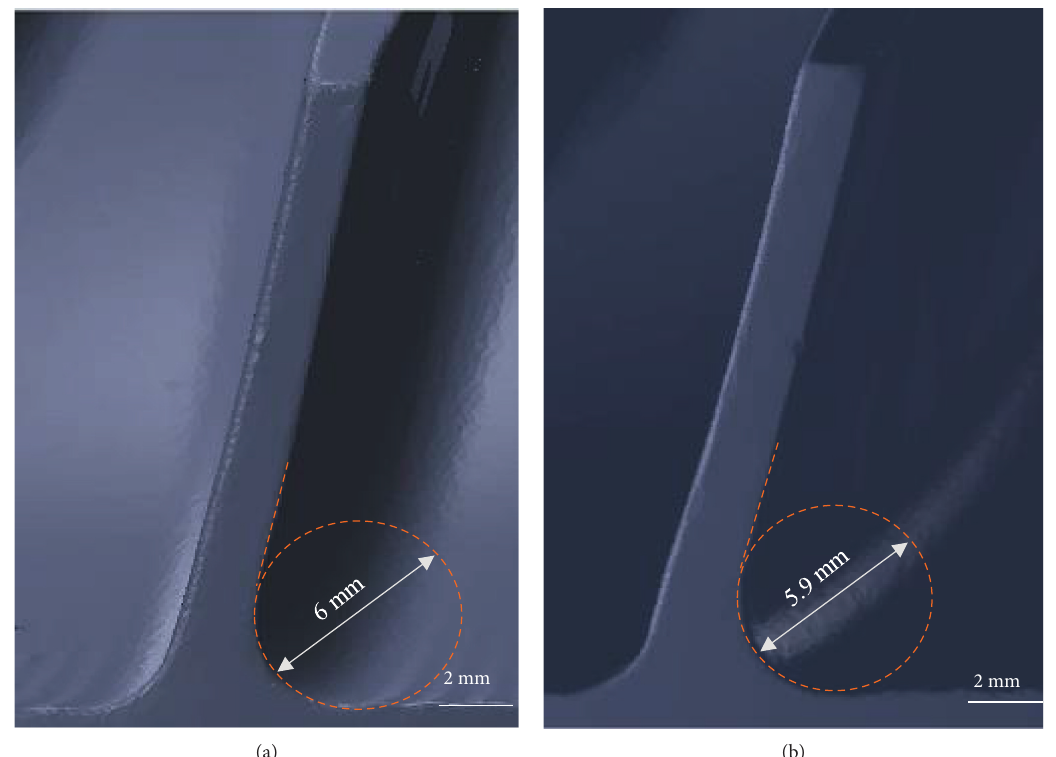
Figures 20: 3D points cloud of sample 3 (a) before service (b) after